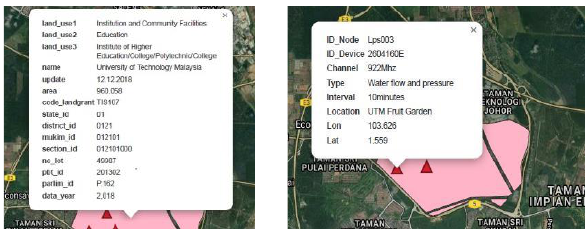
Figure 14. Pop-up attribute data for land use and sensor node information